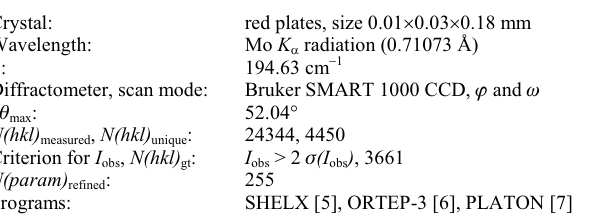
Table 1. Data collection and